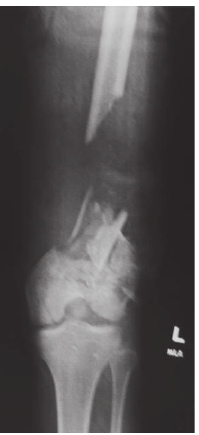
Figure 2: Radiograph following placement of antibiotic cement spacer with lateral distal femoral locking plate